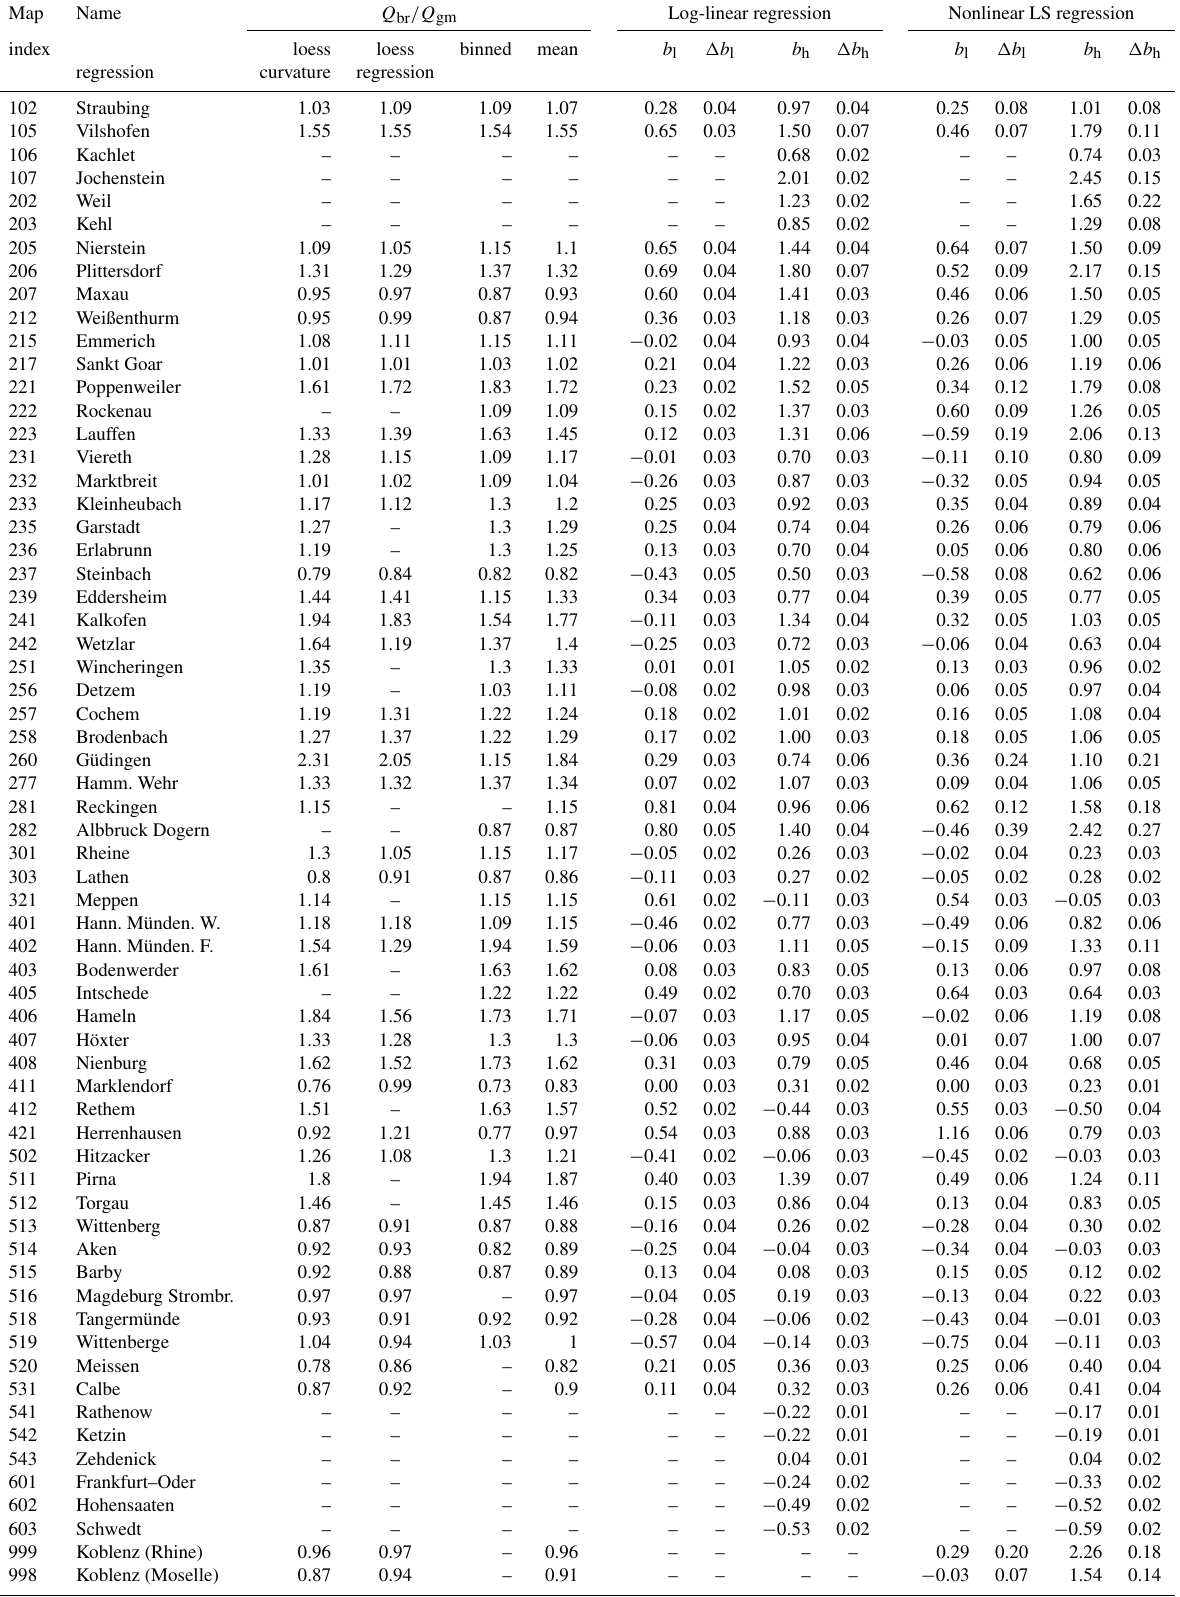
Table 2. Results from rating break analysis and log-linear and nonlinear least-squares regression of the rating exponent (Eq. 2) above ( b h